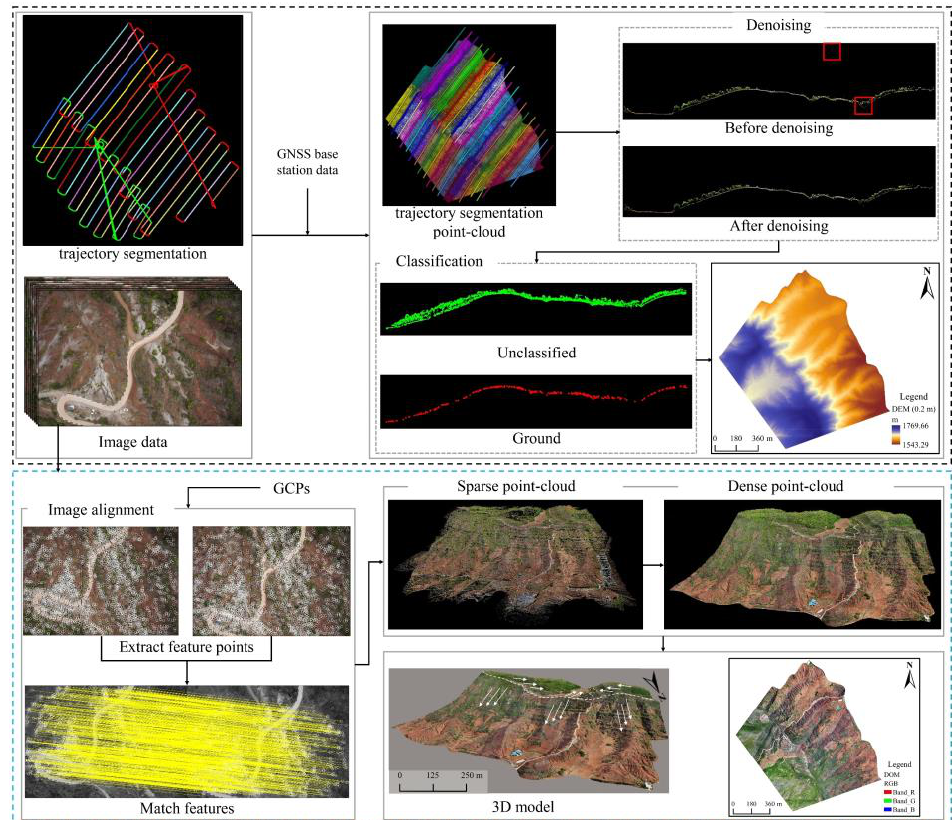
Figure 3. LiDAR point-cloud processing and 3D model construction (the black box represents the LiDAR point-cloud data processing process, and the blue box represents the 3D model construction process).